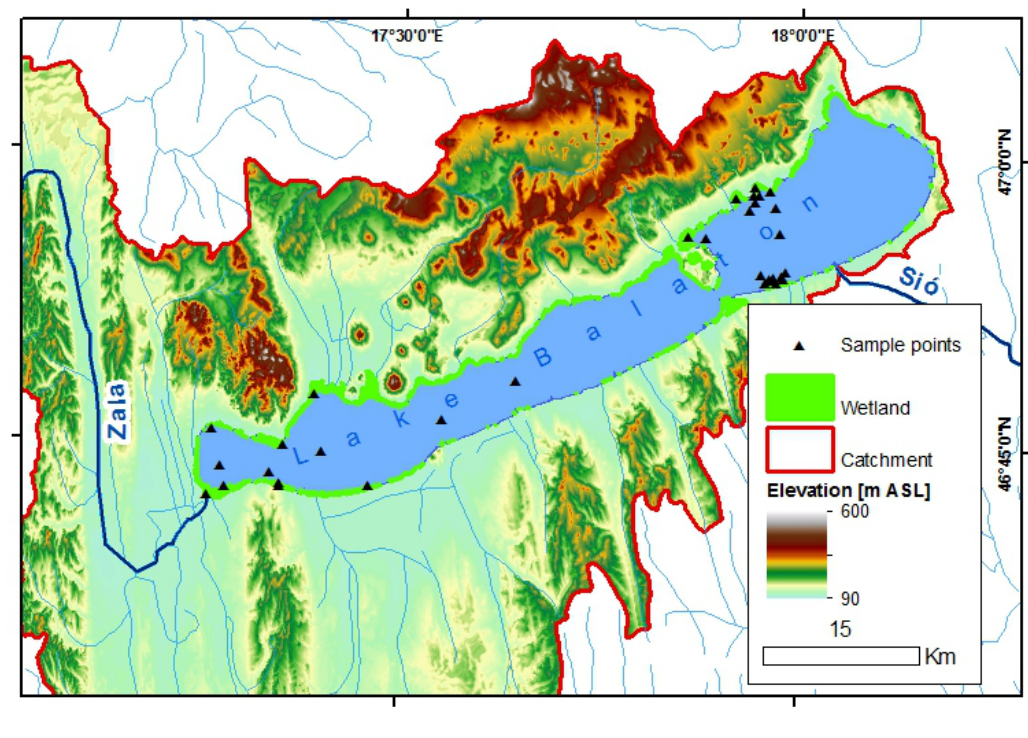
Figure 1. The study site, Lake Balaton, including water sampling